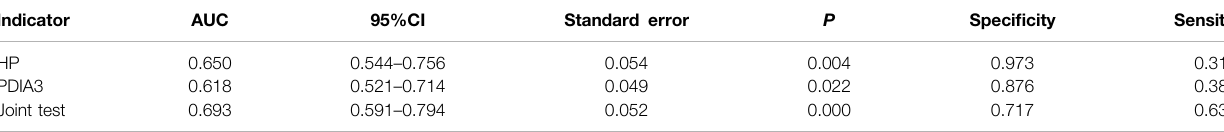
TABLE 6 | Value of HP and PDIA3 levels to assessment of patients with early colorectal cancer. Indicator